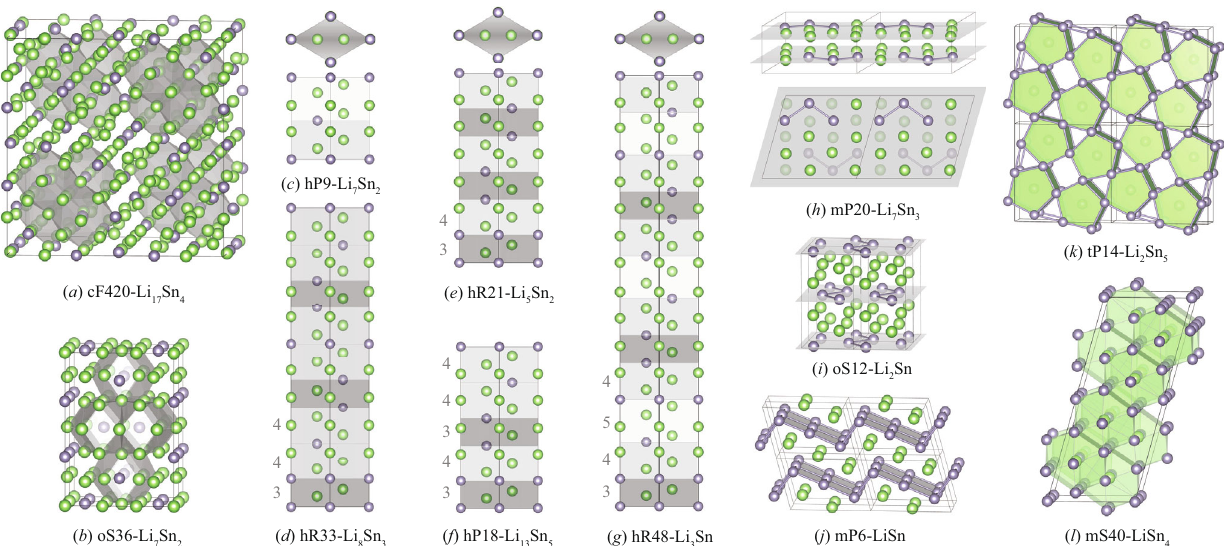
Fig. 5 Select crystal structures of Li-Sn alloys (near)stable under ambient conditions. The displayed phases have been observed experimentally ( a , b , e , f , h , I , k ), proposed previously in refs. 47,50 ( c , d ), and predicted in this study ( g , l ). The Li and Sn atoms are shown in green and gray, respectively, while the shaded polyhedra, sections, and planes highlight distinctive morphological features discussed in the text. The [111] BCC alloys shown in c – g , along with our predicted hR75-Li 19 Sn 6 not included due to its large size, can be uniquely de fi ned with sequences of Sn blocks, e.g., ∣ 3454 ∣ for hR48-Li 3 Sn. These images were generated with the VESTA package 117